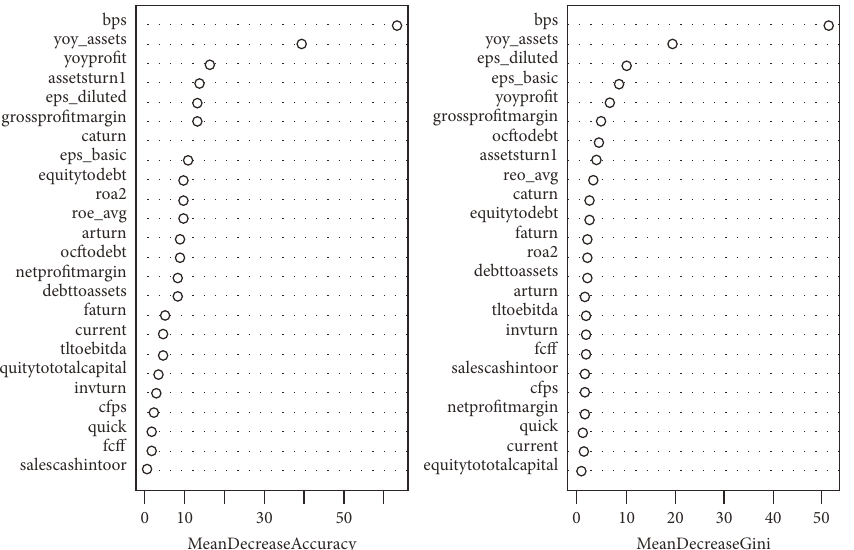
Figure 4: Ranking the importance of indicators in random forests.